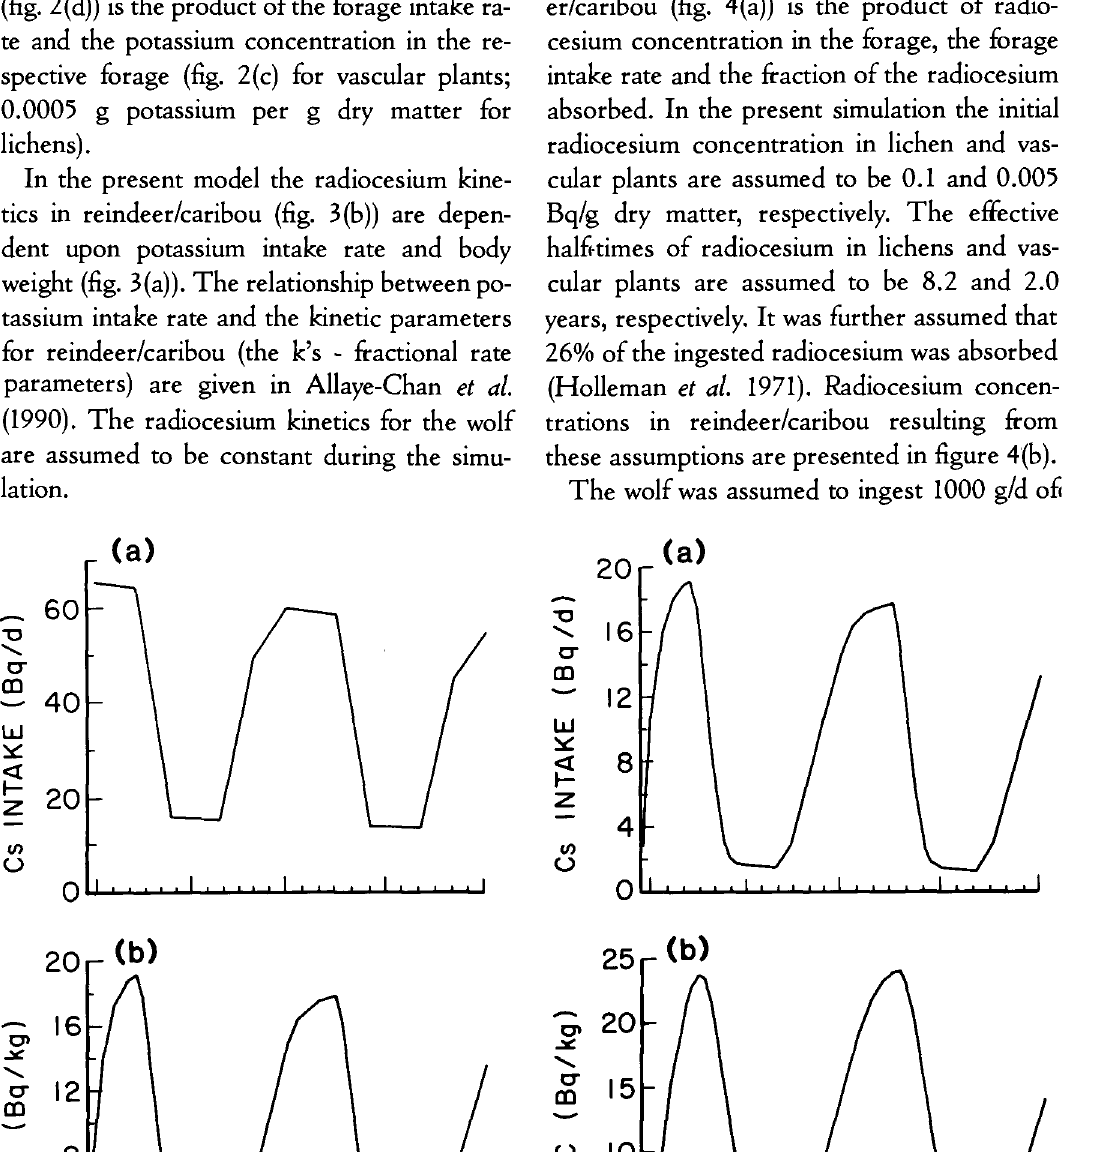
Figure 4. (a) Total radiocesium intake for reindeer/¬ caribou and (b) the resulting radiocesium concentration in skeletal muscle of rein deer/caribou.